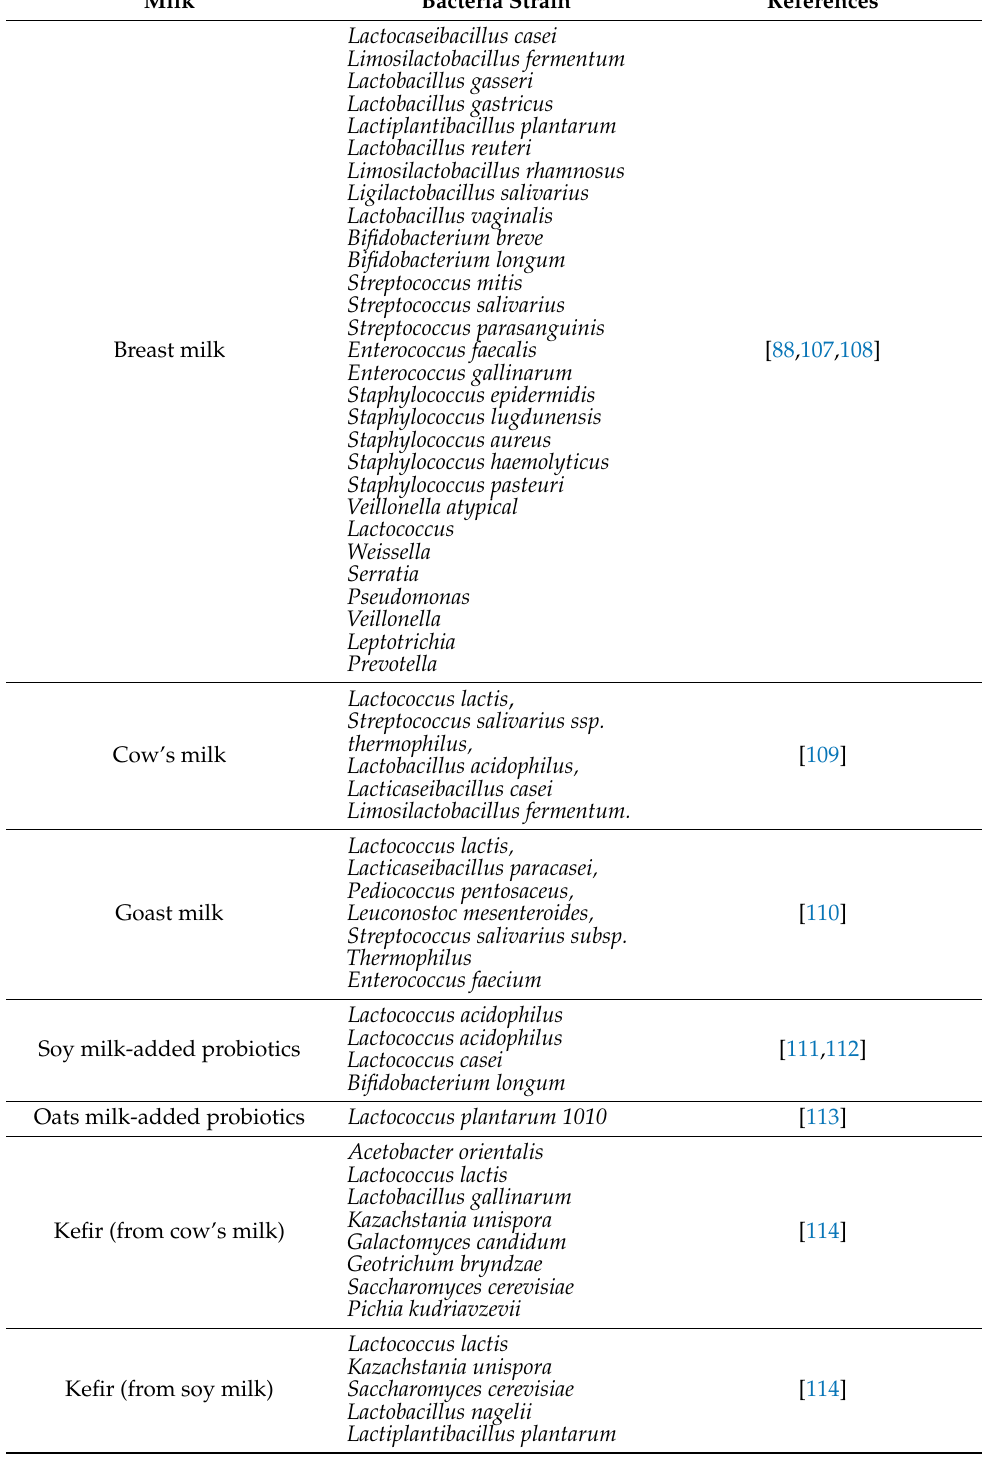
Table 5. Composition of microorganisms in the selected